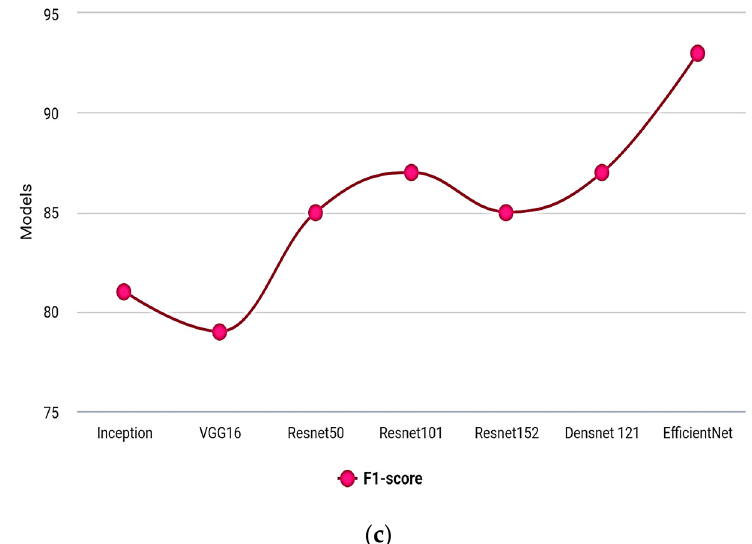
Figure 8. Models vs. ( a ) Precision, ( b ) Recall, ( c ) F1-score.